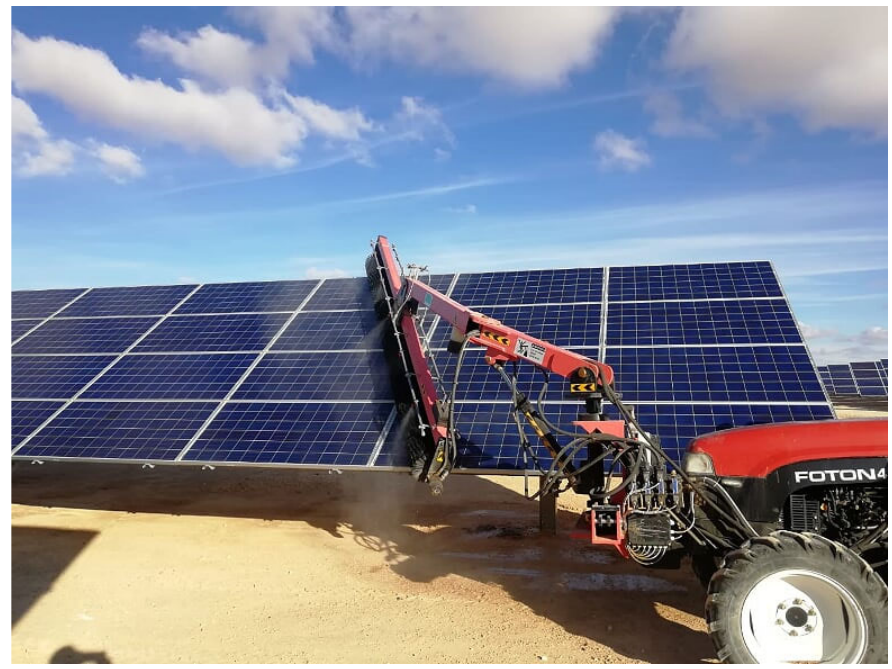
Figure 19. Tractor ‐ mounted hydraulic arm [79].